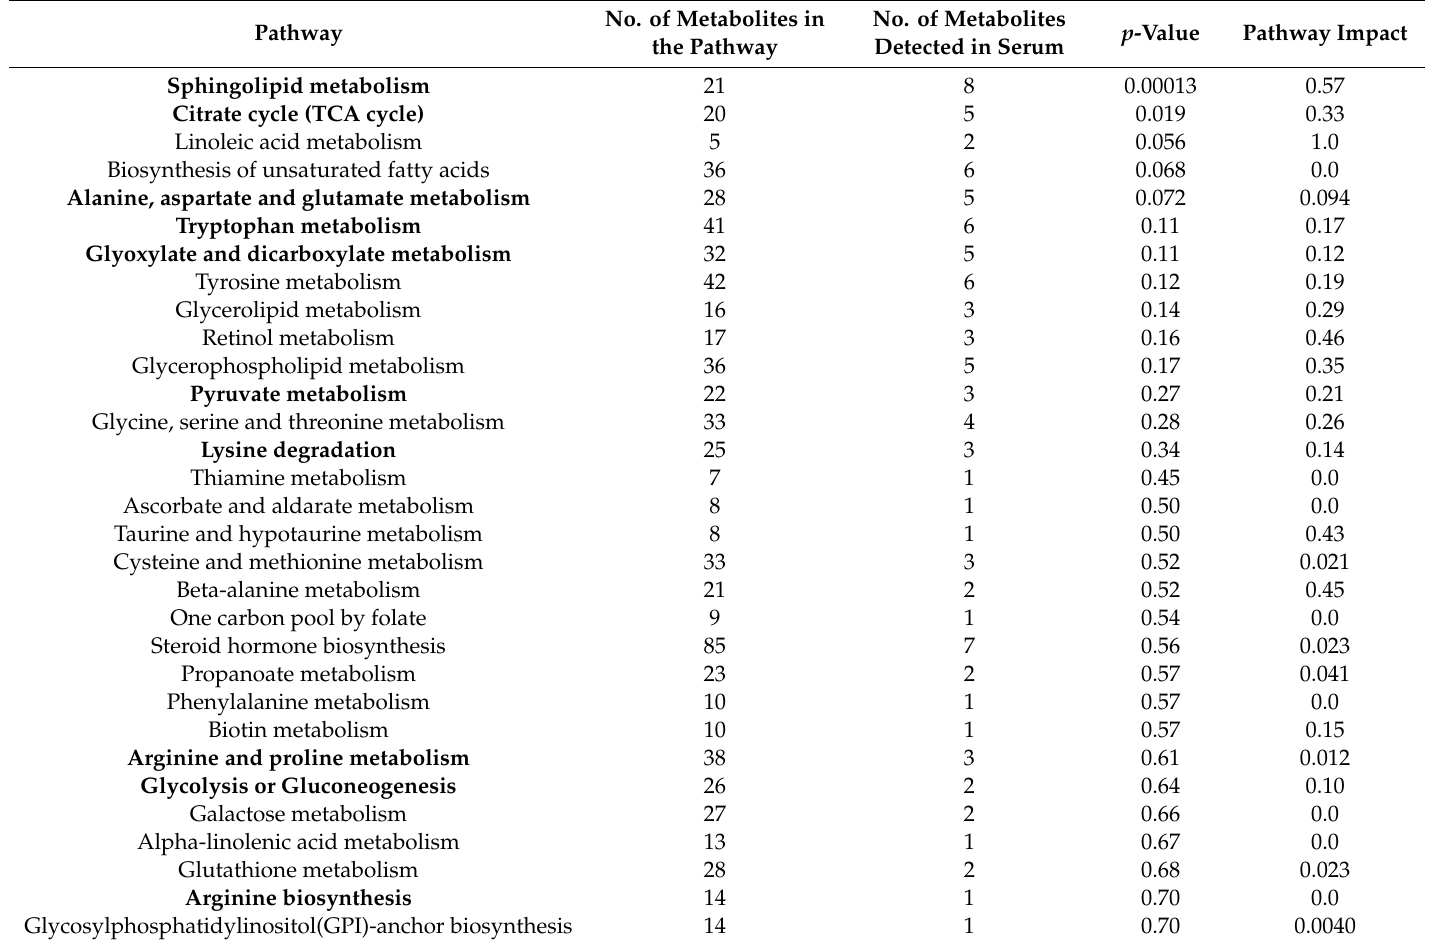
Table 3. Metabolic pathways corresponding to metabolites identified in serum